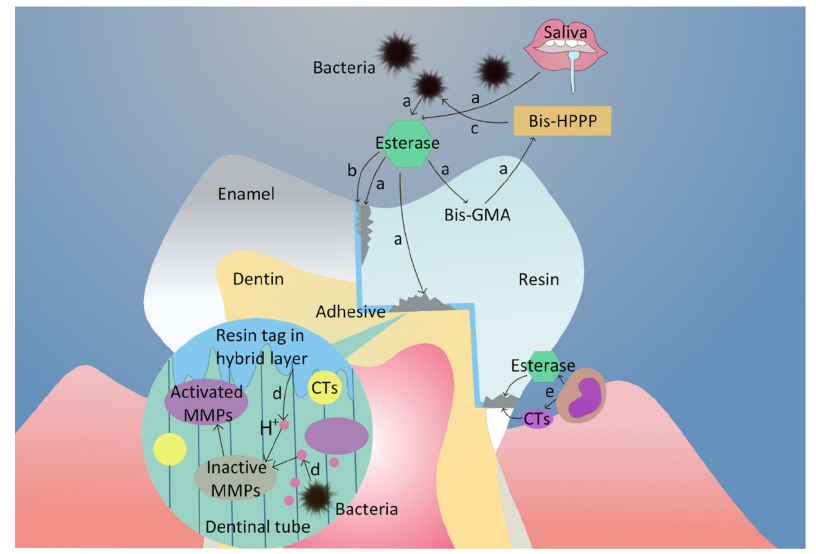
Figure 1. Process of biodegradation. (a) Esterase from cariogenic bacteria and saliva hydrolyzes Bis- GMA in resin restorations to produce Bis-HPPP. (b) Esterase destroys the adhesive layer. (c) Mono- mers in turn promote bacterial growth. (d) Acids from bacteria and etchants activate MMPs. Acti- vated MMPs and CTs degrade dentin collagen fibers together. (e) Neutrophils in gingival crevicular fluid secrete esterase and CTs, then degrade Bis-GMA and dentin collagen fibers on the bonding surface. 4. Monomers Released during Biodegradation and Their Biological Toxicity